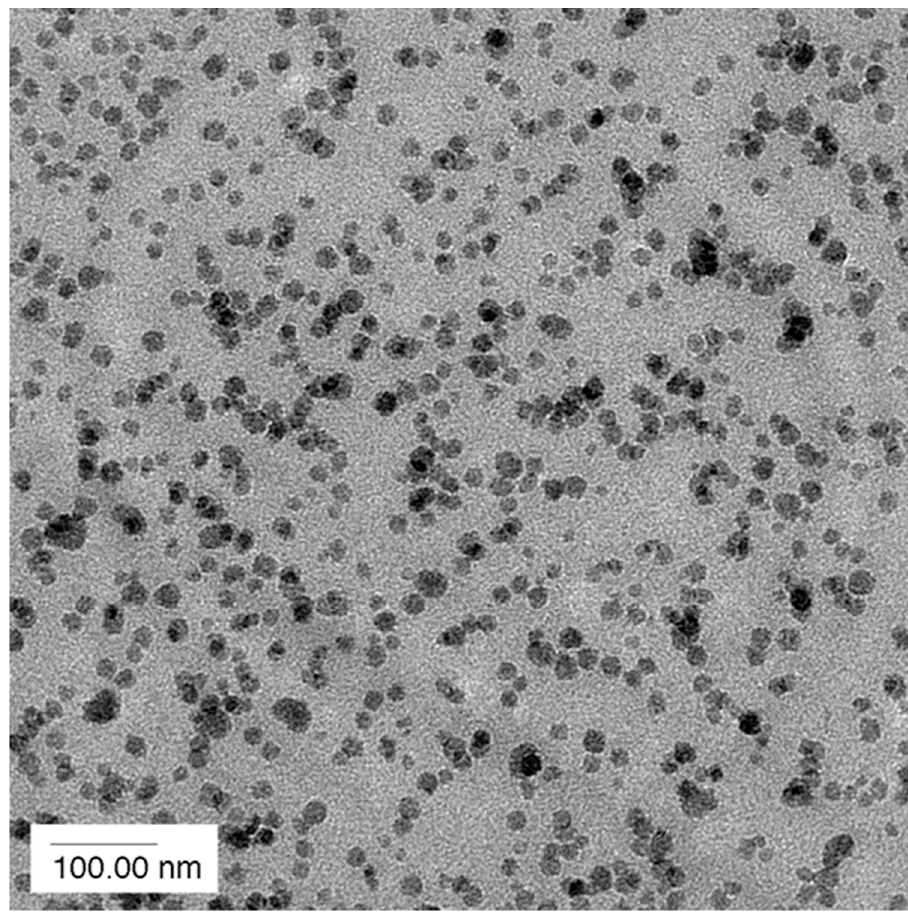
Figure 3. Transmission electron microscopy picture of an epoxy resin with 5 wt % nanosilica [5].